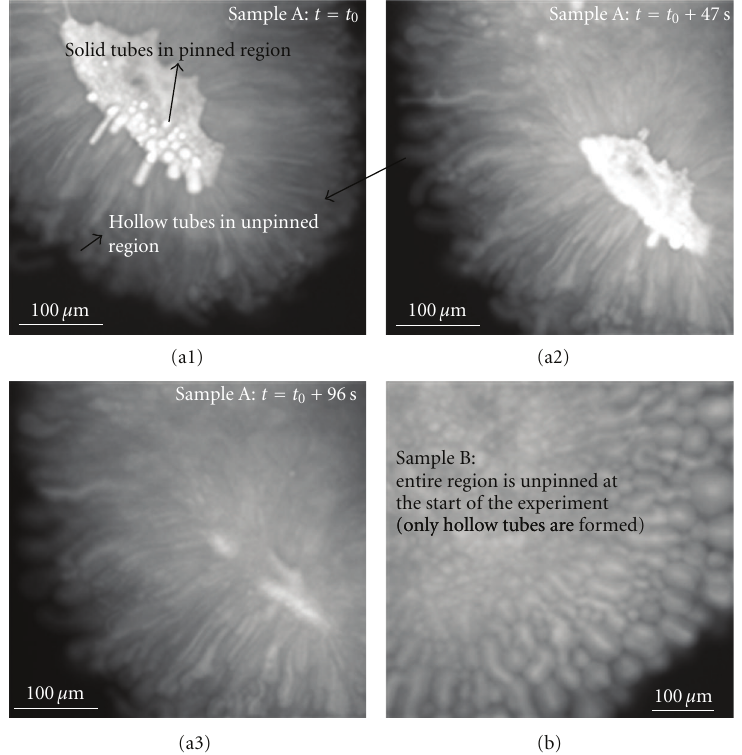
Figure 4: (a1)–(a3) Epifluorescence micrographs reveal coexistence of solid and hollow tubes emanating from single plaque of DMPC (sample A) while edge of the plaque is unpinned from the substrate and its central part is pinned. Protrusion is formed when initially dry lipid plaque is hydrated below T m and then heated to above its T m value. Solid tubes appear from the pinned region and hollow tubes protrude from the unpinned region (a1) and (a2). Over time, the entire plaque becomes unpinned, and all solid tubes retract and are replaced by hollow tubes (a3). (b) Fully suspended DMPC plaques in water produce exclusively hollow tubes. (DMPC is doped with 0.75 mol%